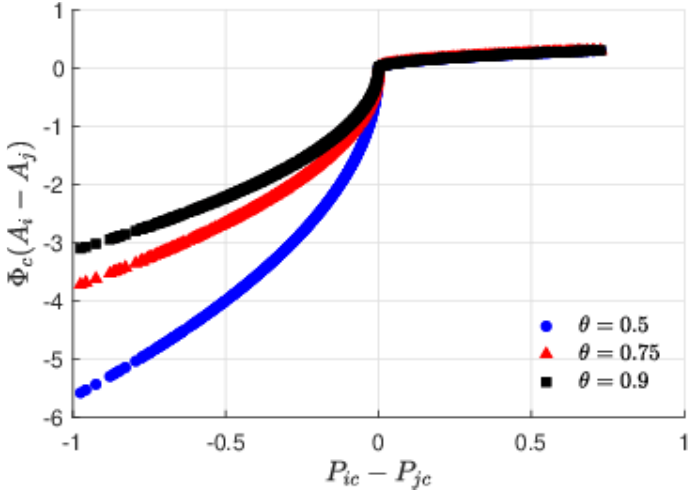
Figure 3. Empirical S-shaped curve for the Sharpe Index. Similar results were found for other performance metrics but are omitted due to space restrictions.